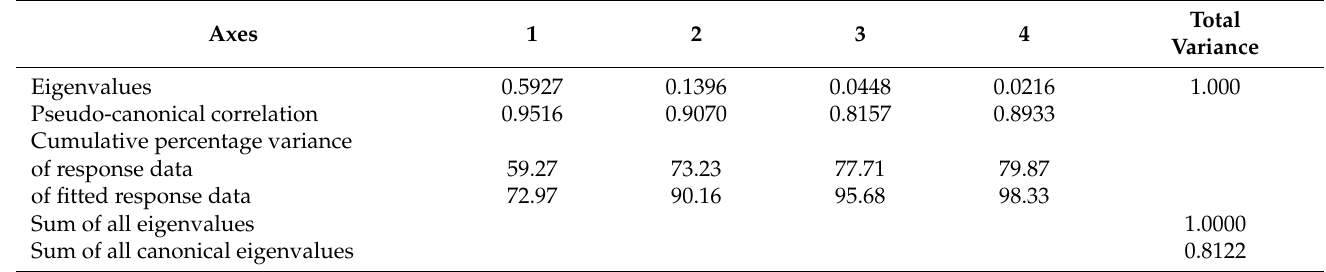
Table 2. Summary statistics for RDA of COVID-19 pandemic-induced feelings and behavior among socio-demographic groups of anglers (response data) versus their preferences and engagement in angling (explanatory variables, VIF * < 10).